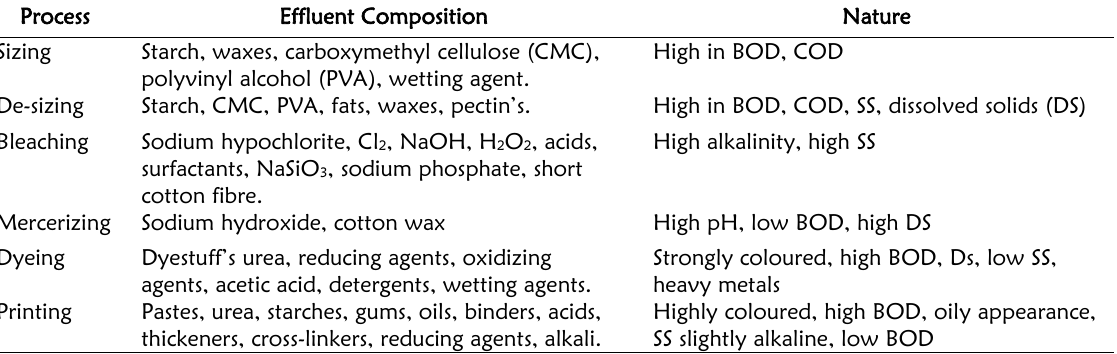
Table 1: Effluent characteristics from textile industry.